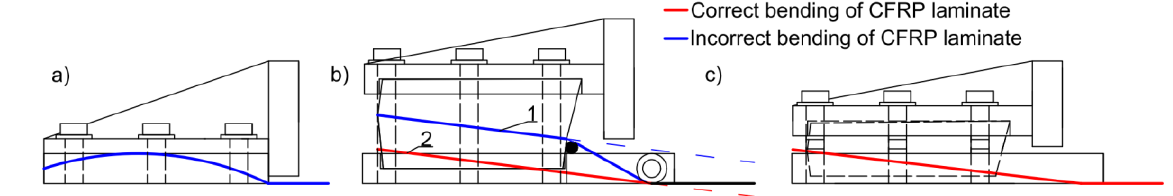
Figure 11. Bending options of CFRP laminate in a clamping unit: ( a ) wavy surface, ( b ) bending with rollers, and ( c ) correct bending of the laminate. Adapted from Ref. [36].